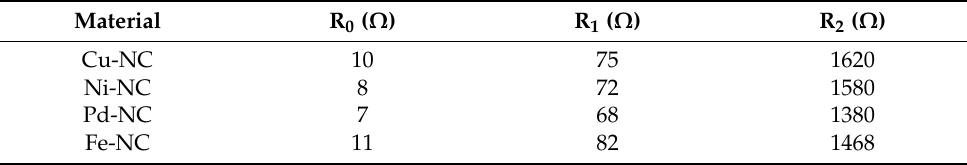
Table 1. R 0 , R 1 , and R 2 of Cu-NC, Ni-NC, Pd-NC, and Fe-NC catalyzed ORR.